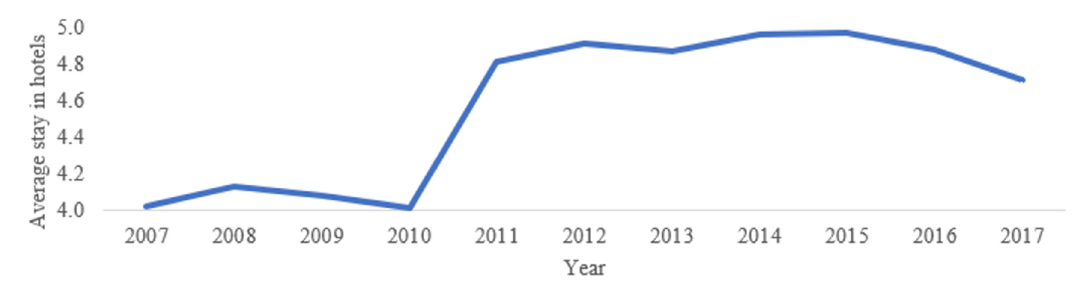
Figure 10. Average stay in hotel units. (Source: Authors).